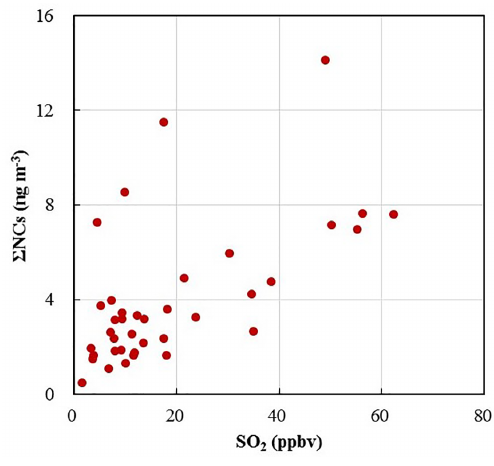
Figure 5. Scatter plot of particulate nitrated phenols with SO 2 in urban Jinan.